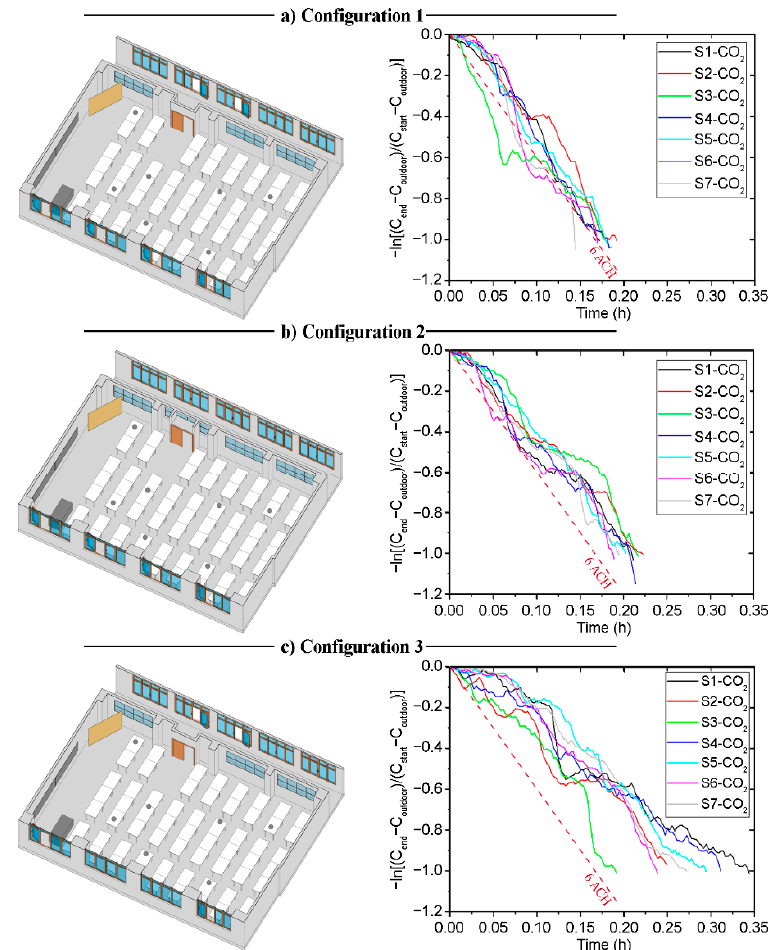
Figure 6. Configuration schemes and decay curves in Classroom B1-A2. ; ( a ) Configuration 1; ( b ) Configuration 2; ( c ) Configuration 3.